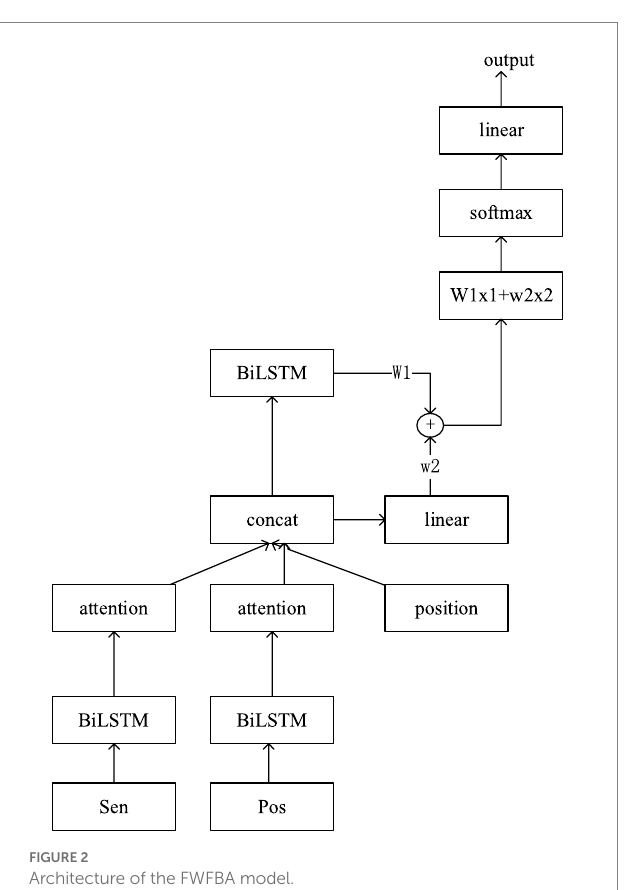
FIGURE 2 Architecture of the FWFBA